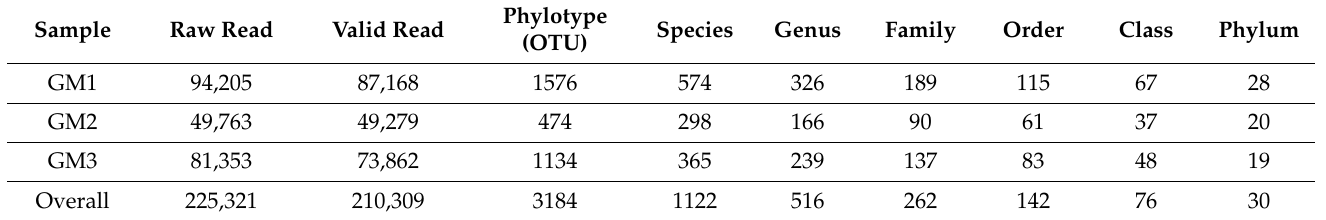
Table 1. Numbers of MiSeq-generated reads, derived OTUs, and annotated taxa in each speleothem sample and the corresponding overall total numbers. Note that the overall total taxa numbers are smaller than simple sums of those for GM1, GM2, and GM3 due to overlaps among